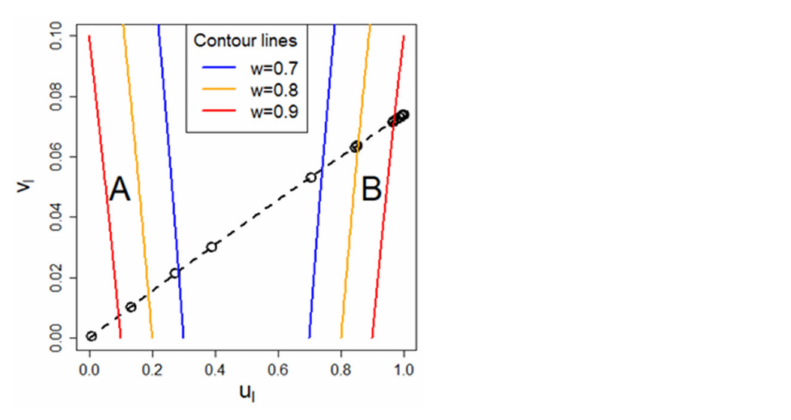
Figure 5. A segment of the regime graph is shown. The dashed line indicates the possible positions of any substance for the water borne wall paint scenario in the regime graph. In total, the positions of 18 substances are represented by empty circles. ( A ) denotes the quick release regime, while ( B ) denotes the near equilibrium regime. Contour lines for both regimes are shown